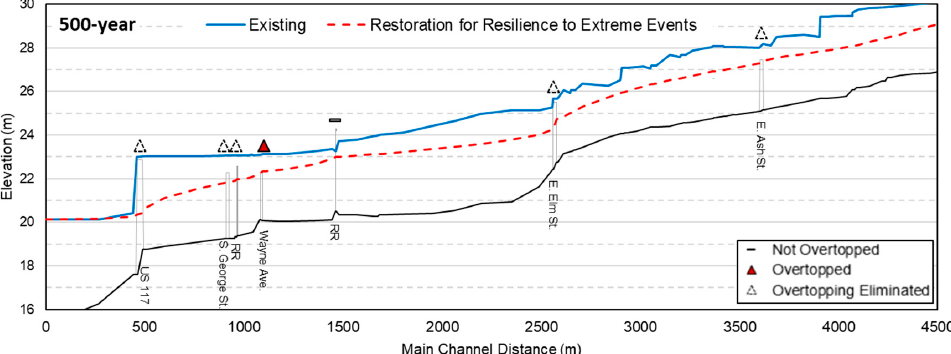
Figure 11. Water surface profiles for the Existing Condition and the Restoration for Resilience to Extreme Events scenario for the 500-year event. Water 2020 , 12 , x FOR PEER REVIEW